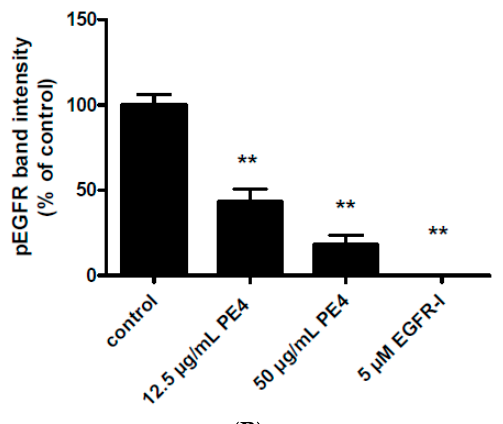
Figure 6. Inhibition of EGFR phosphorylation in A431 cells. A431 cells were treated for 15 min with PE4 at a concentration of 12.5 and 50 µg/mL or with the EGFR tyrosine kinase inhibitor (EGFR-I) AG1478 (5 µM). Untreated cells served as control. Subsequently the cells were stimulated for 5 min with 50 ng/mL EGF. ( A ) Afterwards the cells were lysed and prepared for western blotting with anti-EGFR, anti-phosphoEGFR (pEGFR) and anti- β actin antibodies; ( B ) The graph shows the band intensity of the western blot. The pEGFR/tubulin quotient was equaled to 100%. Data are expressed as means ± SD of three independent experiments and the statistical significance was determined compared to the untreated control (** p < 0.01).